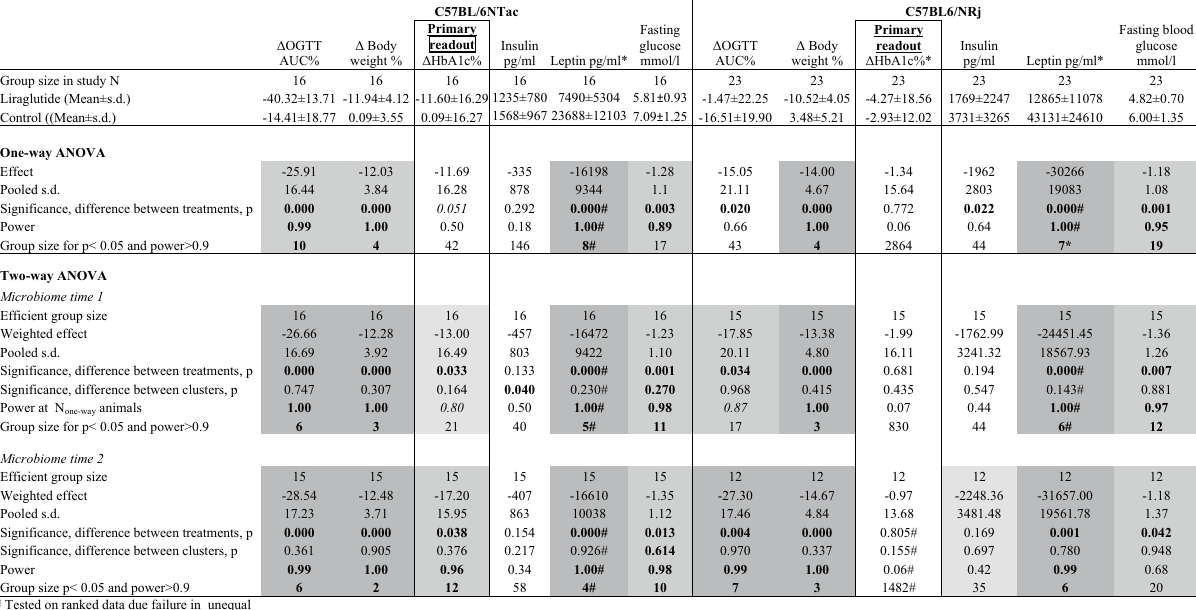
Table 2. Clinico-chemical parameters from testing the effect of liraglutide in of diet-induced obese C57BL/6NTac mice and C57BL/6NRj and the subsequent evaluation by either one-way ANOVA or two-way ANOVA including treatment and either microbiomic clusters before (time 1) or after diet induction (time 2) a factor. Power is written in bold if > 0.90 and in italics if 0.80 - 0.90. Significant values are in bold. Italics: borderline significance (p <